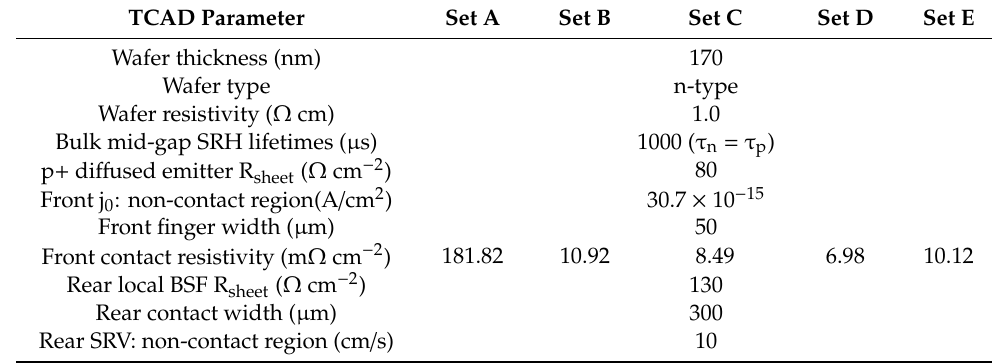
Figure 8. Energy loss analysis of recombination components for co-firing temperature profile sets a TCAD tool. using a TCAD tool. Table 2. Detailed TCAD parameters for free energy loss analysis by co-firing temperature profile